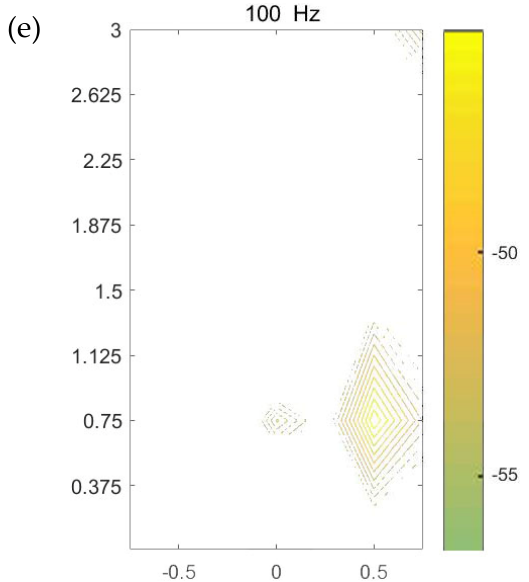
Figure 13. Contour image based on CobMode for Figure 12.